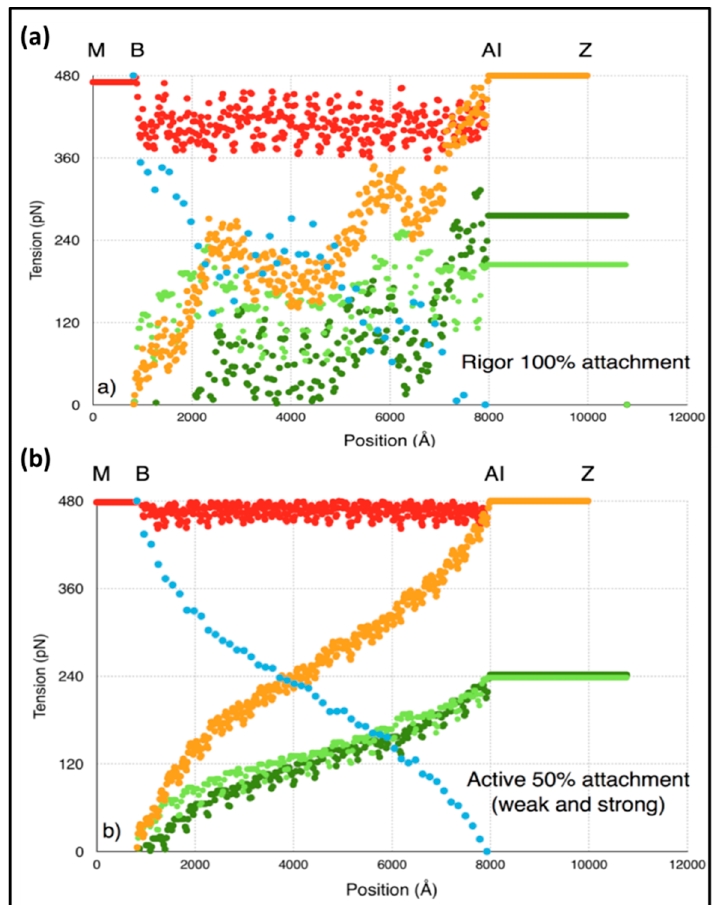
Figure A6. Tension through the half sarcomere, averaged over several possible initial configurations, using Model 3 for ( a ) 100% attachment and ( b ) 50% attachment. The tension along the myosin filament is depicted in blue, along one set of equivalent actins in light green and along the other set of equivalent actins in dark green. Their sum, corresponding to the tension along all actins, is depicted in orange. The summed tensions (actin plus myosin) along the A-band are depicted in red. In both cases k m = 720 pN/Å for the myosin filament, k a = 2280 pN/Å for the actin filament and k h = 0.8 pN/Å for the heads.